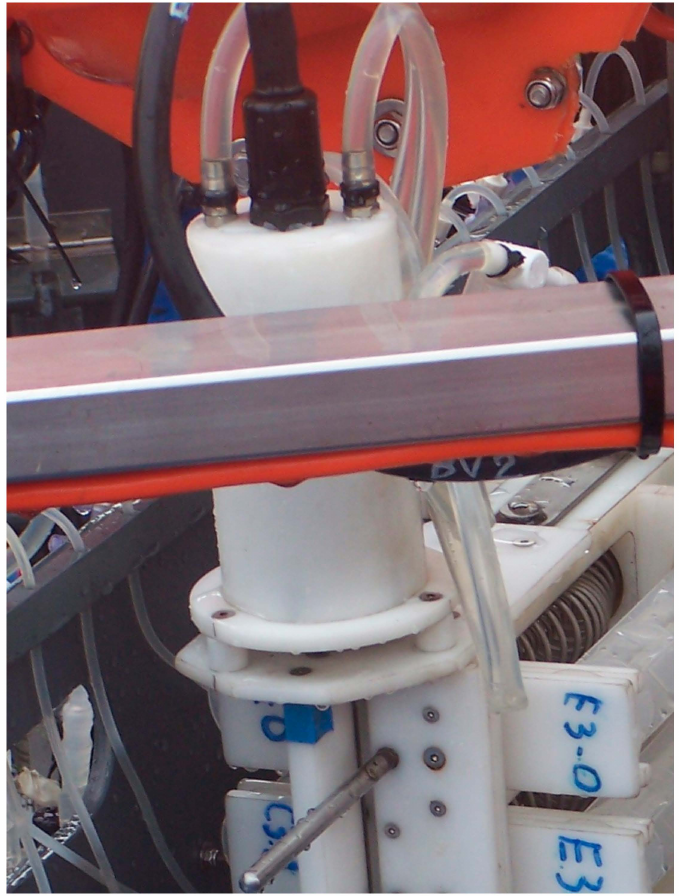
Figure 12. The Delrin case hosting the electric motors with the silicone tube pressure-compensation